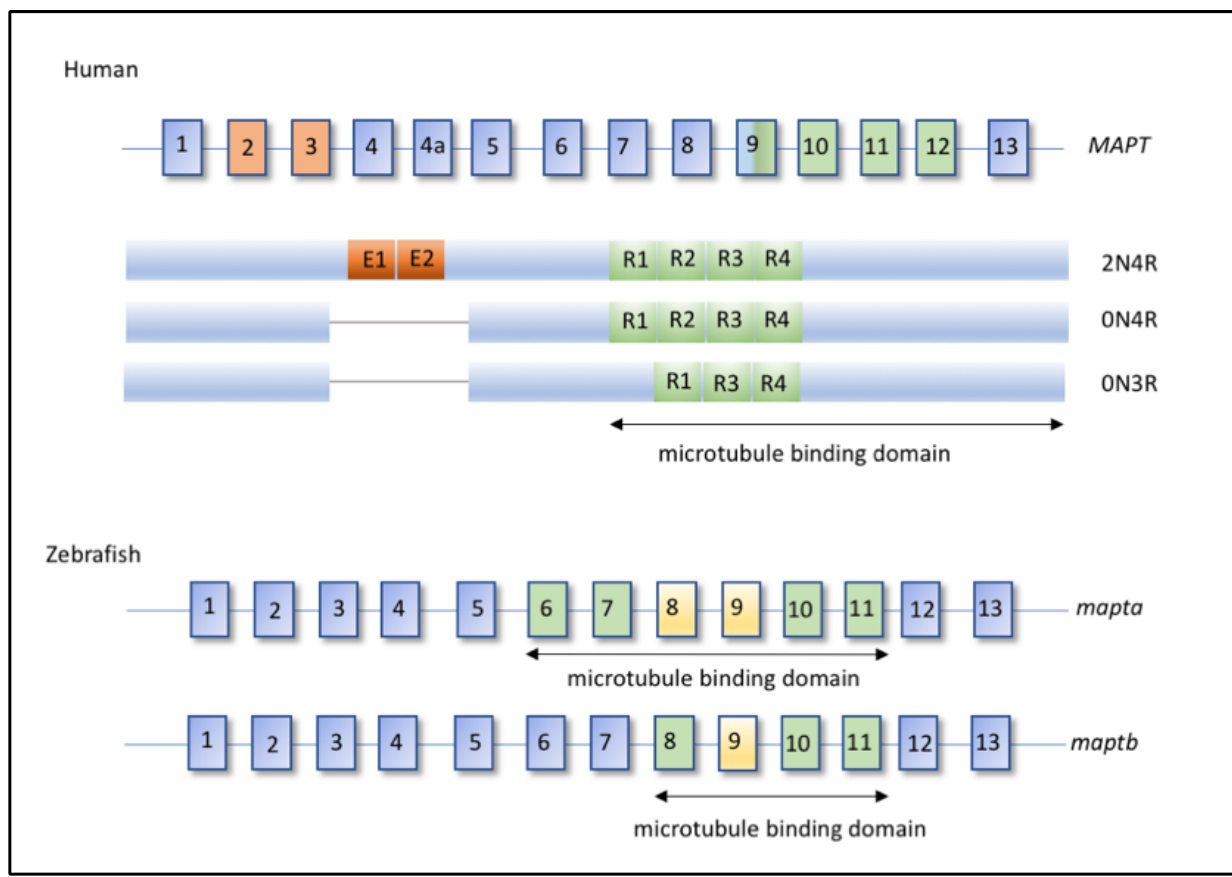
Figure 1. Organization of the human and zebrafish MAPT genes. Human MAPT gene is represented with the major isoforms used in transgenic models and found in patients, 2N4R, 0N4R, and 0N3R. Orange exons encode N-terminal domain and green exons encode repeats domain (R) that belong to microtubule binding domains. Exon 10 is alternatively spliced to generate 3R isoform. Zebrafish mapta and maptb genes have 13 exons each (blue), with green exons encoding microtubule binding domains, and yellow one labelling alternatively spliced exons.